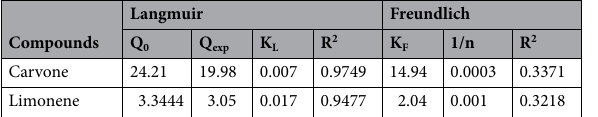
Table 5. Equilibrium adsorption parameters according to Langmuir and Freundlich models.